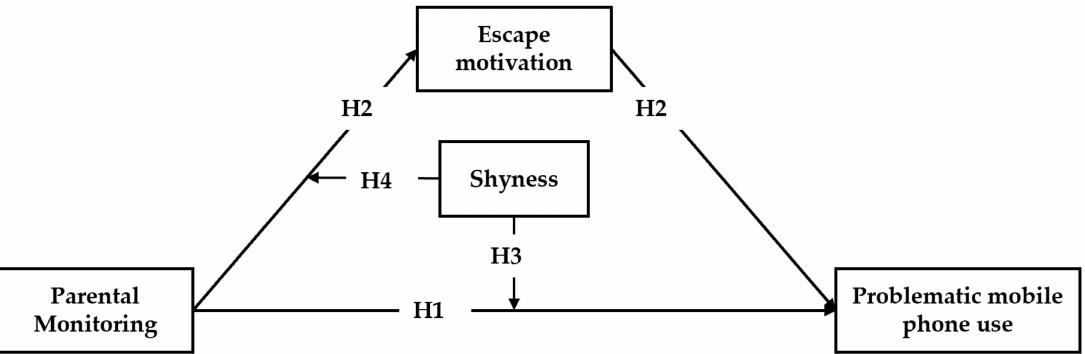
Figure 1. The hypothesized